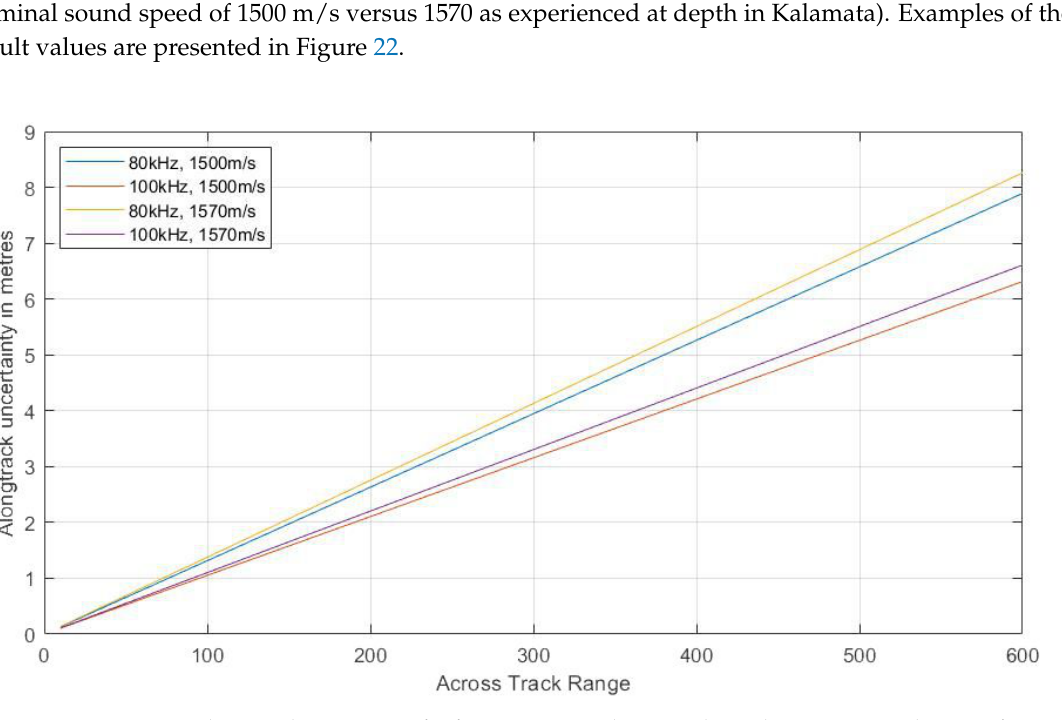
Figure 22. HISAS along track uncertainty for frequencies equal to 80 and 1000 kHz, at 1500 and 1570 m/s.